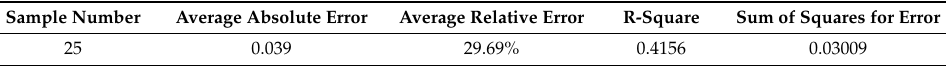
Table 2. Comparison of inversion AOD and MOD 04 AOD. The R-square denotes the coefficient of fitting determination.